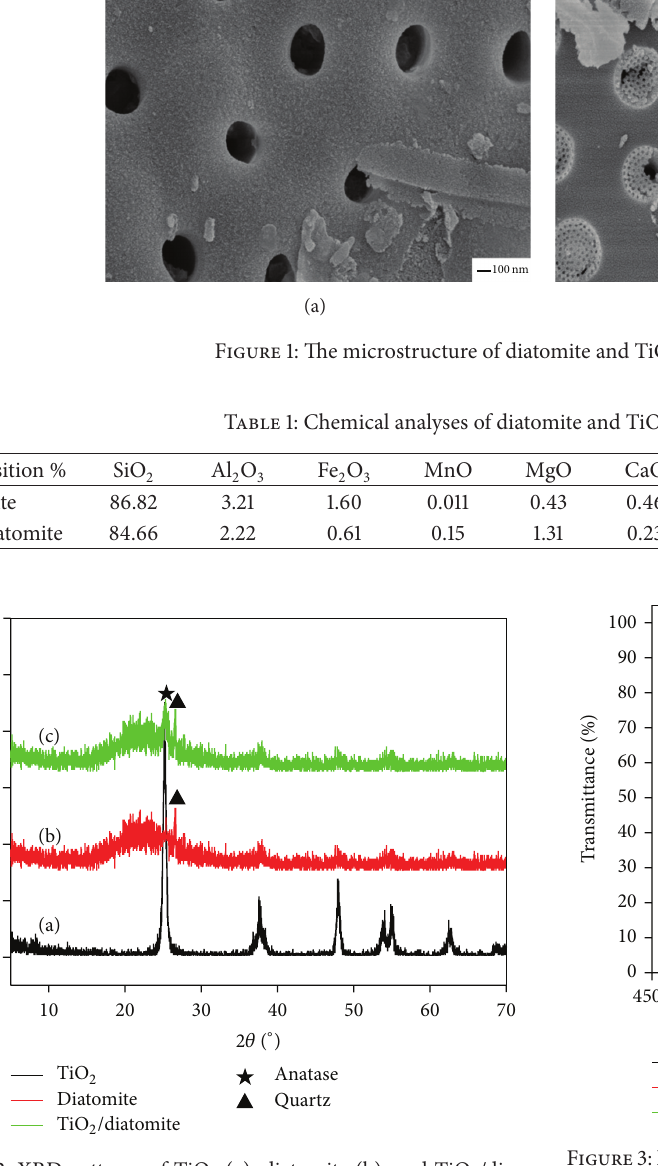
Figure 2: XRD patterns of TiO 2 (a), diatomite (b), and TiO 2 /dia- tomite composite (c).